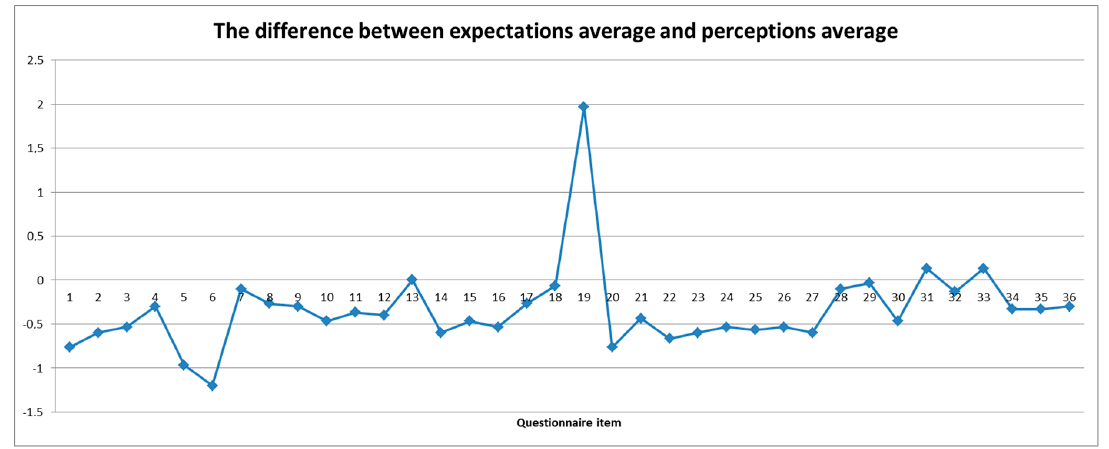
Figure 7. The charts of the di ff erence between expectations average and perceptions average (source: own study).